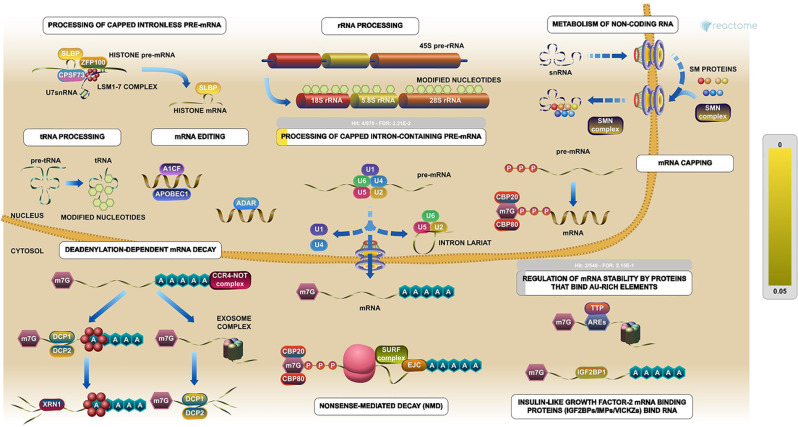
Pathway enrichments of SHGS. PRPF4, SRSF1, HNRNPM, and DHX9 are keys genes in the RNA metabolic pathway. These genes especially are involved in the preprocessing of capped intron-containing pre-mRNA and regulation of mRNA stability by proteins that bind AU-rich elements. (Image extracted from the Reactome pathway analyzer).